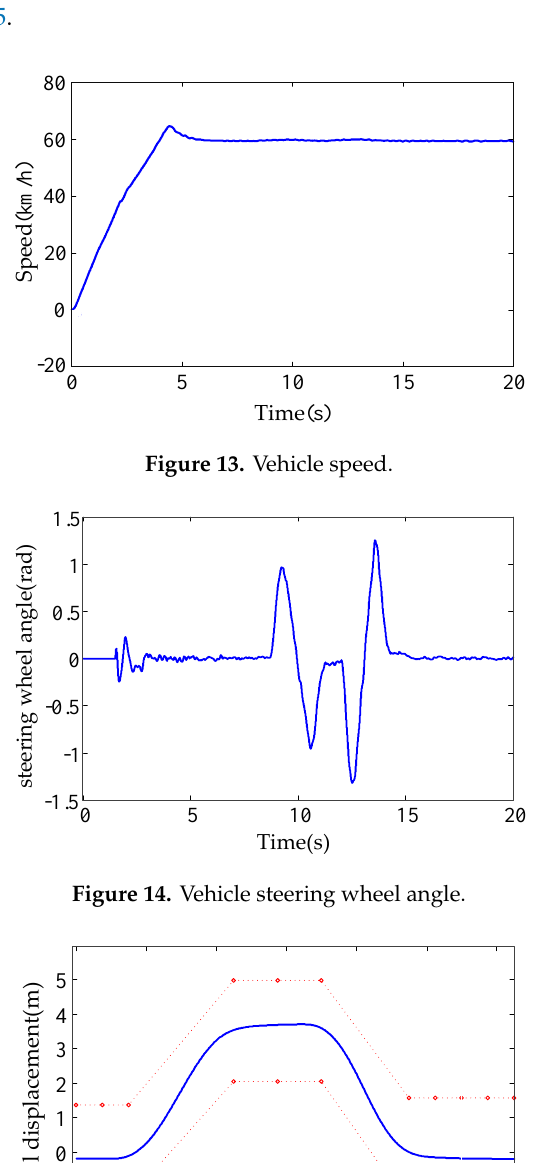
Figure 12. Vehicle model with IASS in veDYNA.